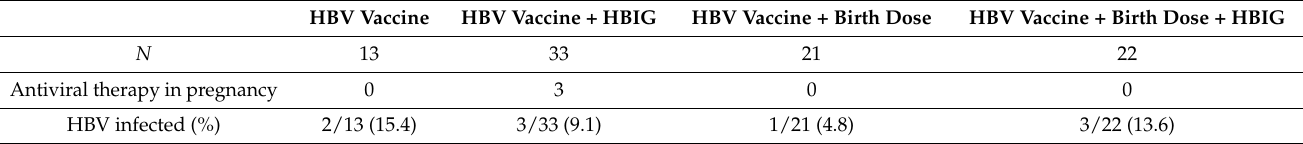
Table 3. Immunization status and HBV infection of 89 children born to HBsAg positive mothers in Ethiopia.